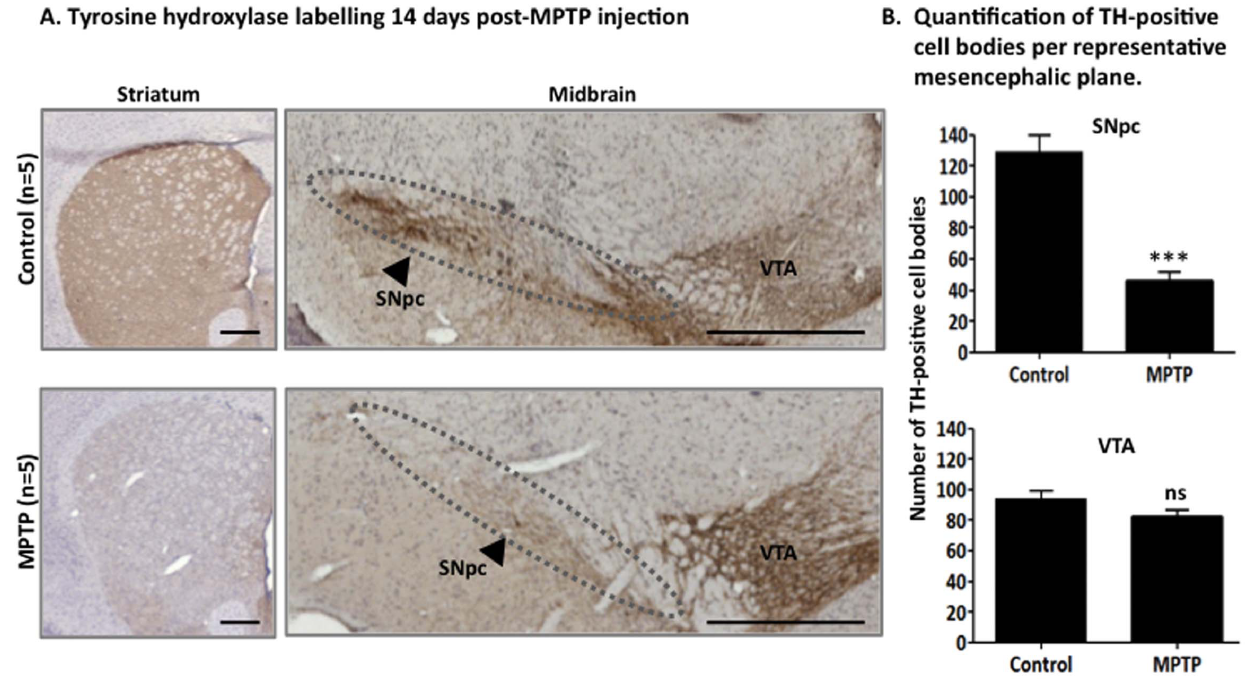
Figure 2. Validation of the MPTP mouse model of dopaminergic cell degeneration. A. Tyrosine hydroxylase (TH) immunostaining ( brown , hematoxylin-stained nuclei) of dopaminergic fibers in the striatum and neurons in the midbrain of control and acute MPTP-treated mice. B. Number of TH-positive cell bodies per representative mesencephalic plane (Mean 6 SEM). The number of dopaminergic neurons in the SNpc of MPTP-treated mice is significantly decreased compared to control (p , 0,001, One-way ANOVA), while the VTA dopaminergic neurons are not strongly affected (p . 0,05, One-way ANOVA). (Scale bars=500 m m).